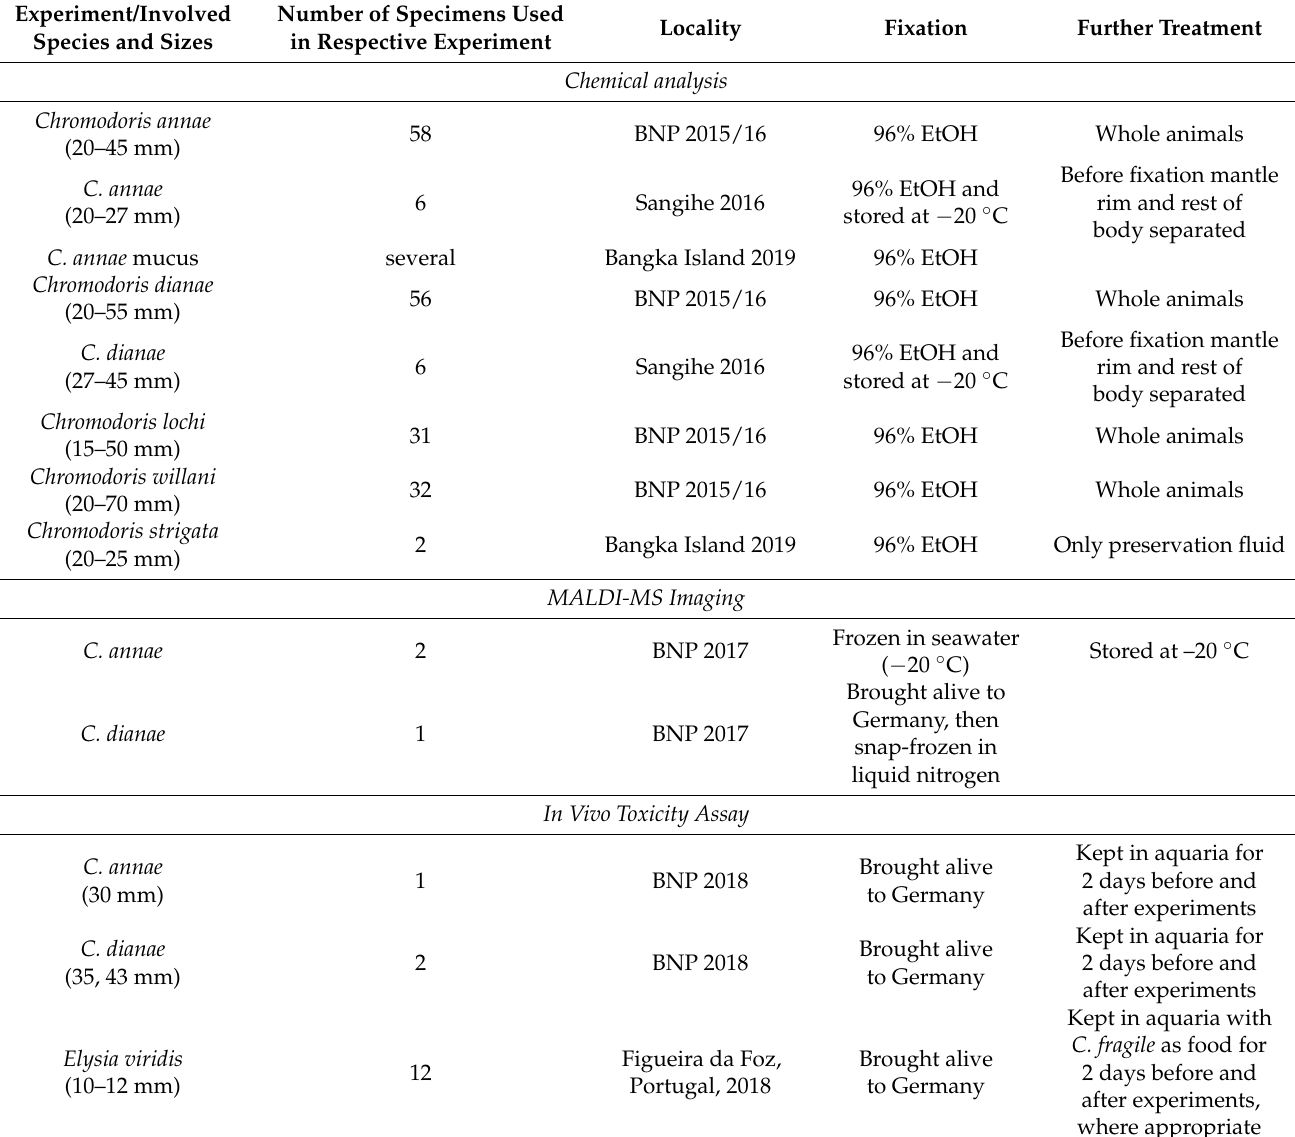
Table 1. Species names and further details of the specimens analyzed in this study, and the experi- ments in which the specimens were used. BNP Bunaken National Park, North